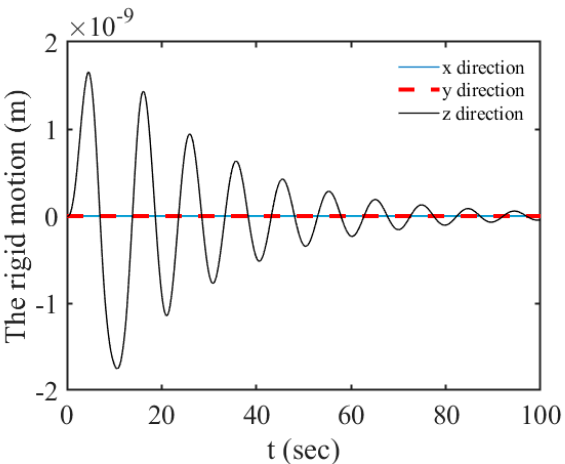
Figure 6. The translation of the spacecraft under the τ ( k = 50 N · m/rad ).